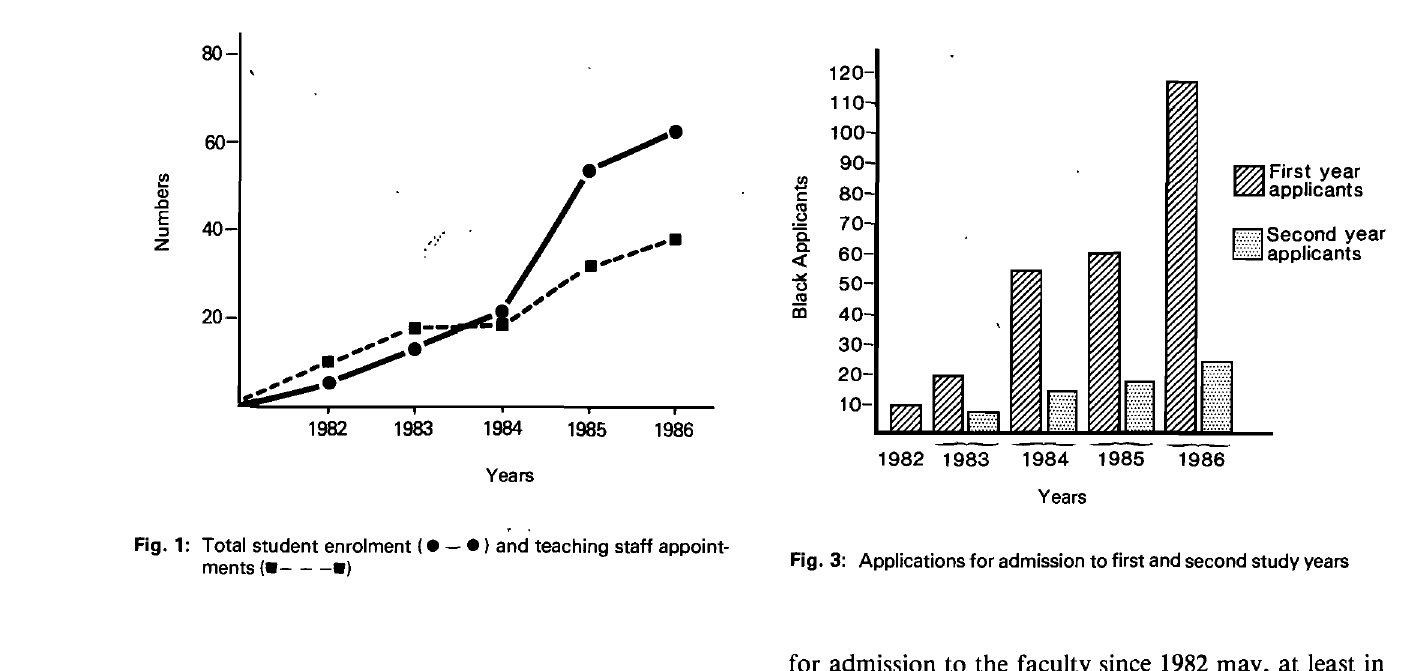
Fig. 3: Applications for admission to first and second study